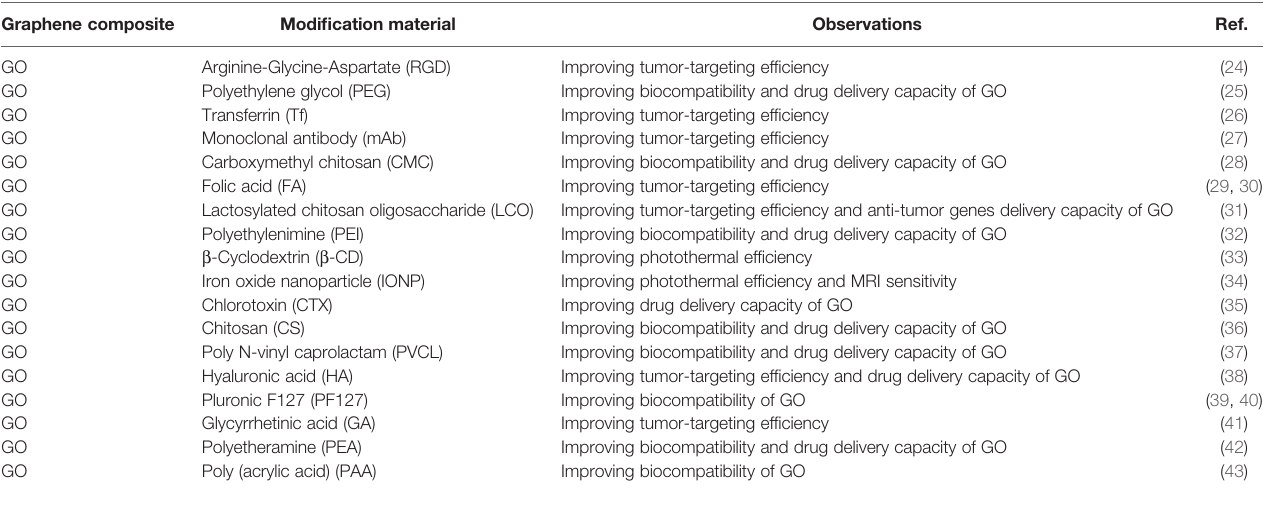
TABLE 1 | A brief summary of functional modi fi cations of GO. Graphene